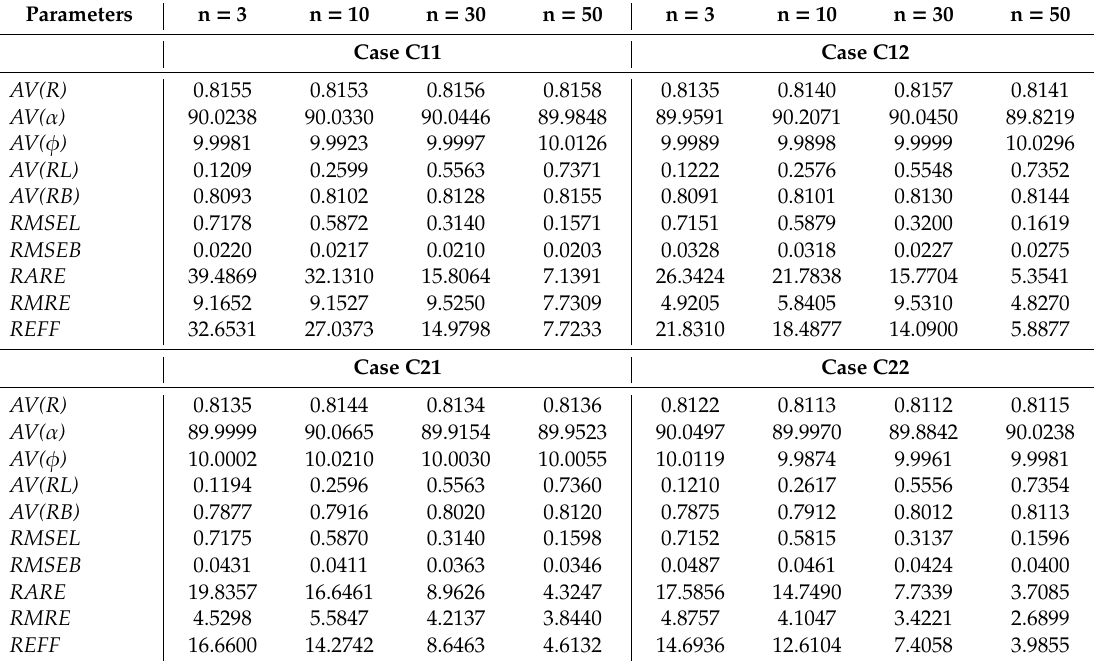
Table 5. Simulation results for cases